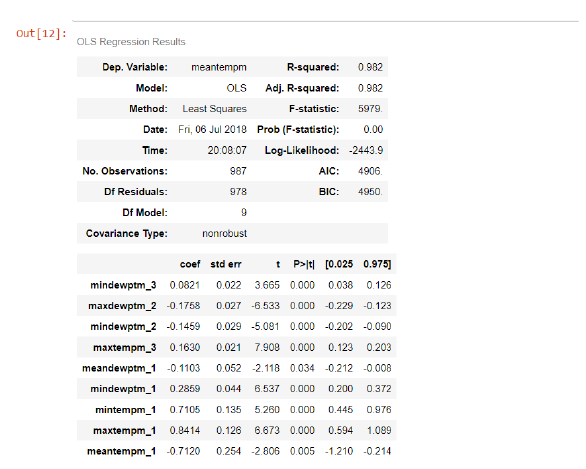
Figure 3. OLS model results 4.3. Calculated Errors